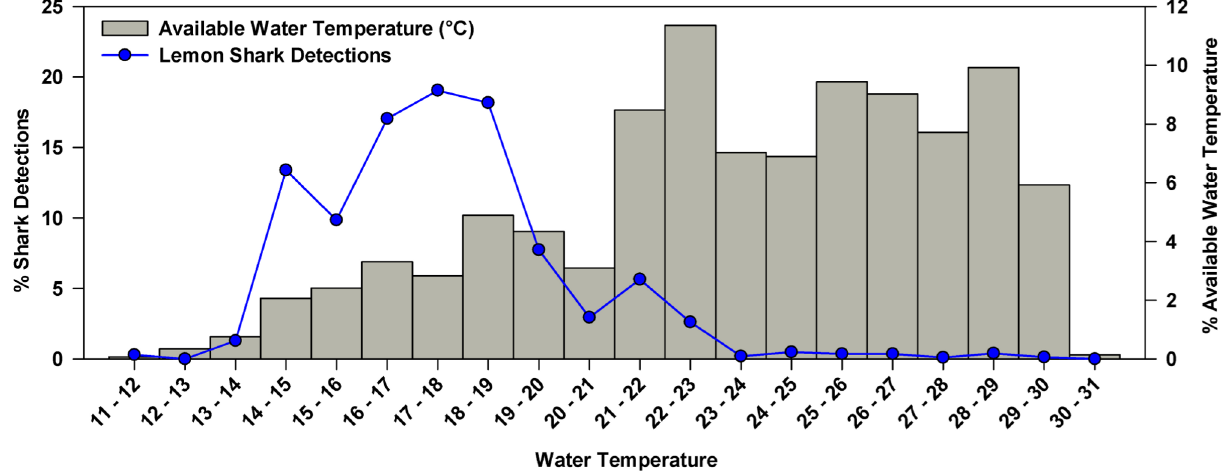
Figure 5. Distribution of available water temperature at Cape Canaveral and associated percentage of lemon shark detections. Water temperature was derived from daily means recorded December 2008 through December